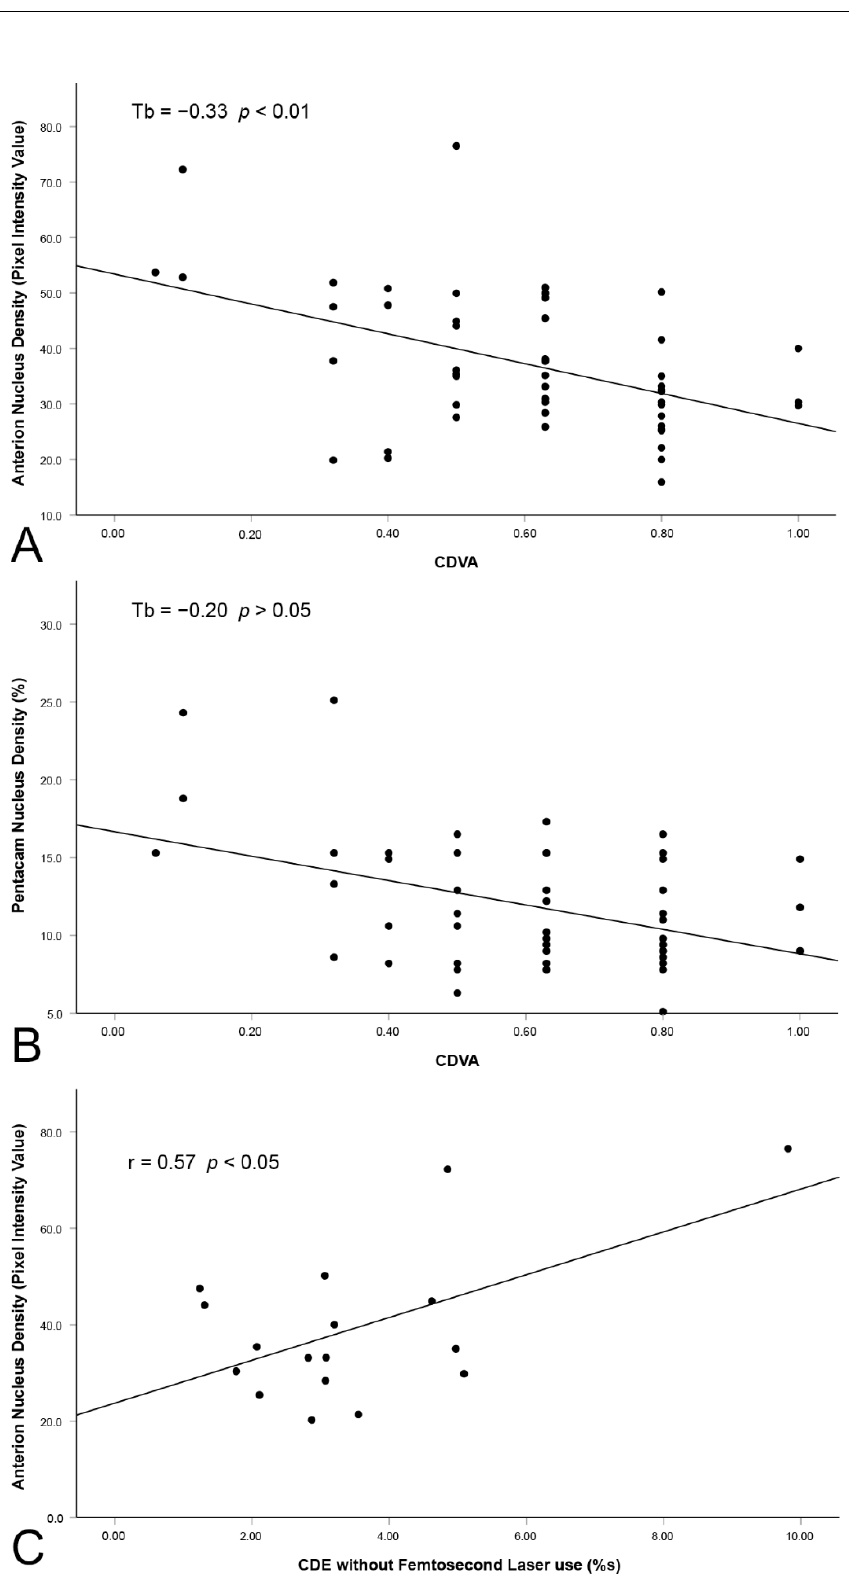
ultrasonic energy ranging from 1.24 %s to 9.81 %s, with a mean of 3.26 ± 1.79 %s. A statis- tically significant correlation (Table 2) was found with all the SS-OCT analysis methods